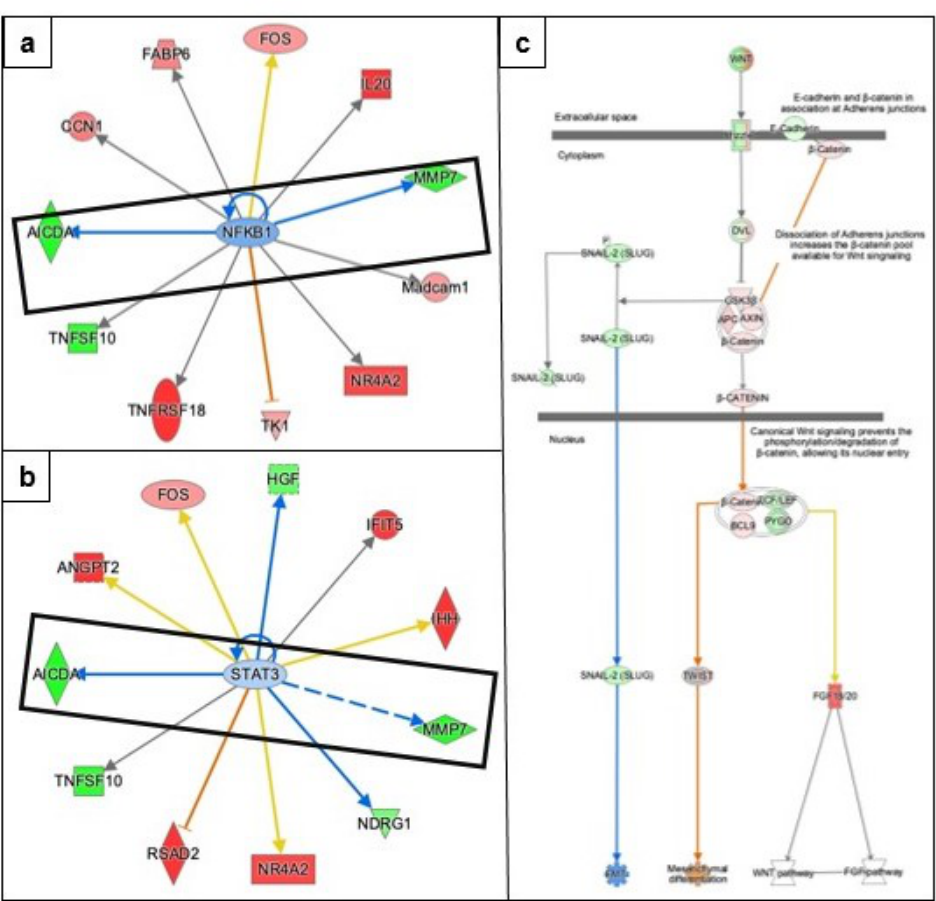
Figure 5. Effect of metformin on epithelial–mesenchymal transition predicted by IPA. Up-stream analysis in IPA predicts the activation/inhibition of various transcription factors. ( a , b ) Transcription factors involved in EMT, NFKB, and STAT3 are predicted to be inhibited due to the downregulation of MMP7 and AICDA. ( c ) Canonical WNT signaling pathway involved in EMT was overlaid with dataset molecules that lead to a predicted inhibition of EMT acting downregulation of SNAIl-2 (SLUG). The key for the shape, color, direction, and molecule types in the above pathways is provided in Figure